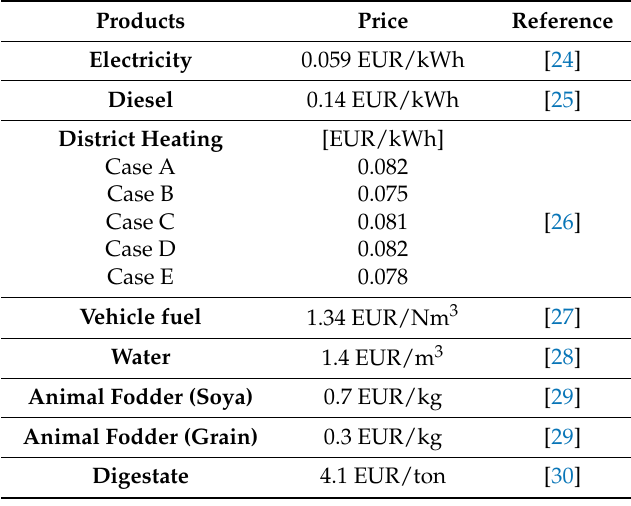
Table A2. Prices for different products used or sold in this study.